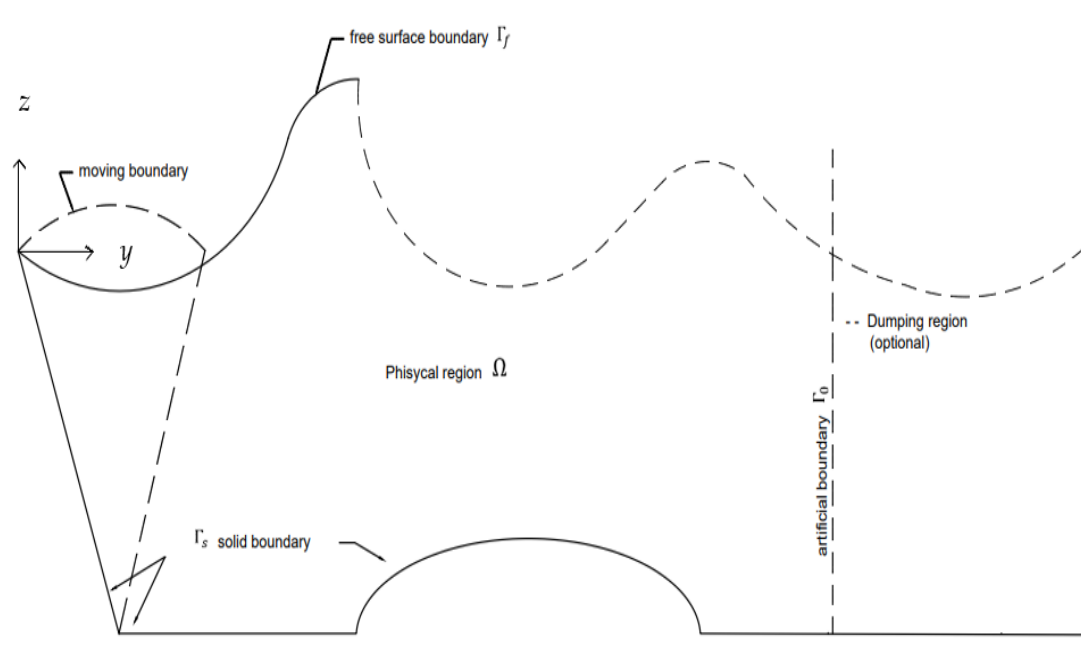
Figure A1. Definitions sketch of the flow domain.